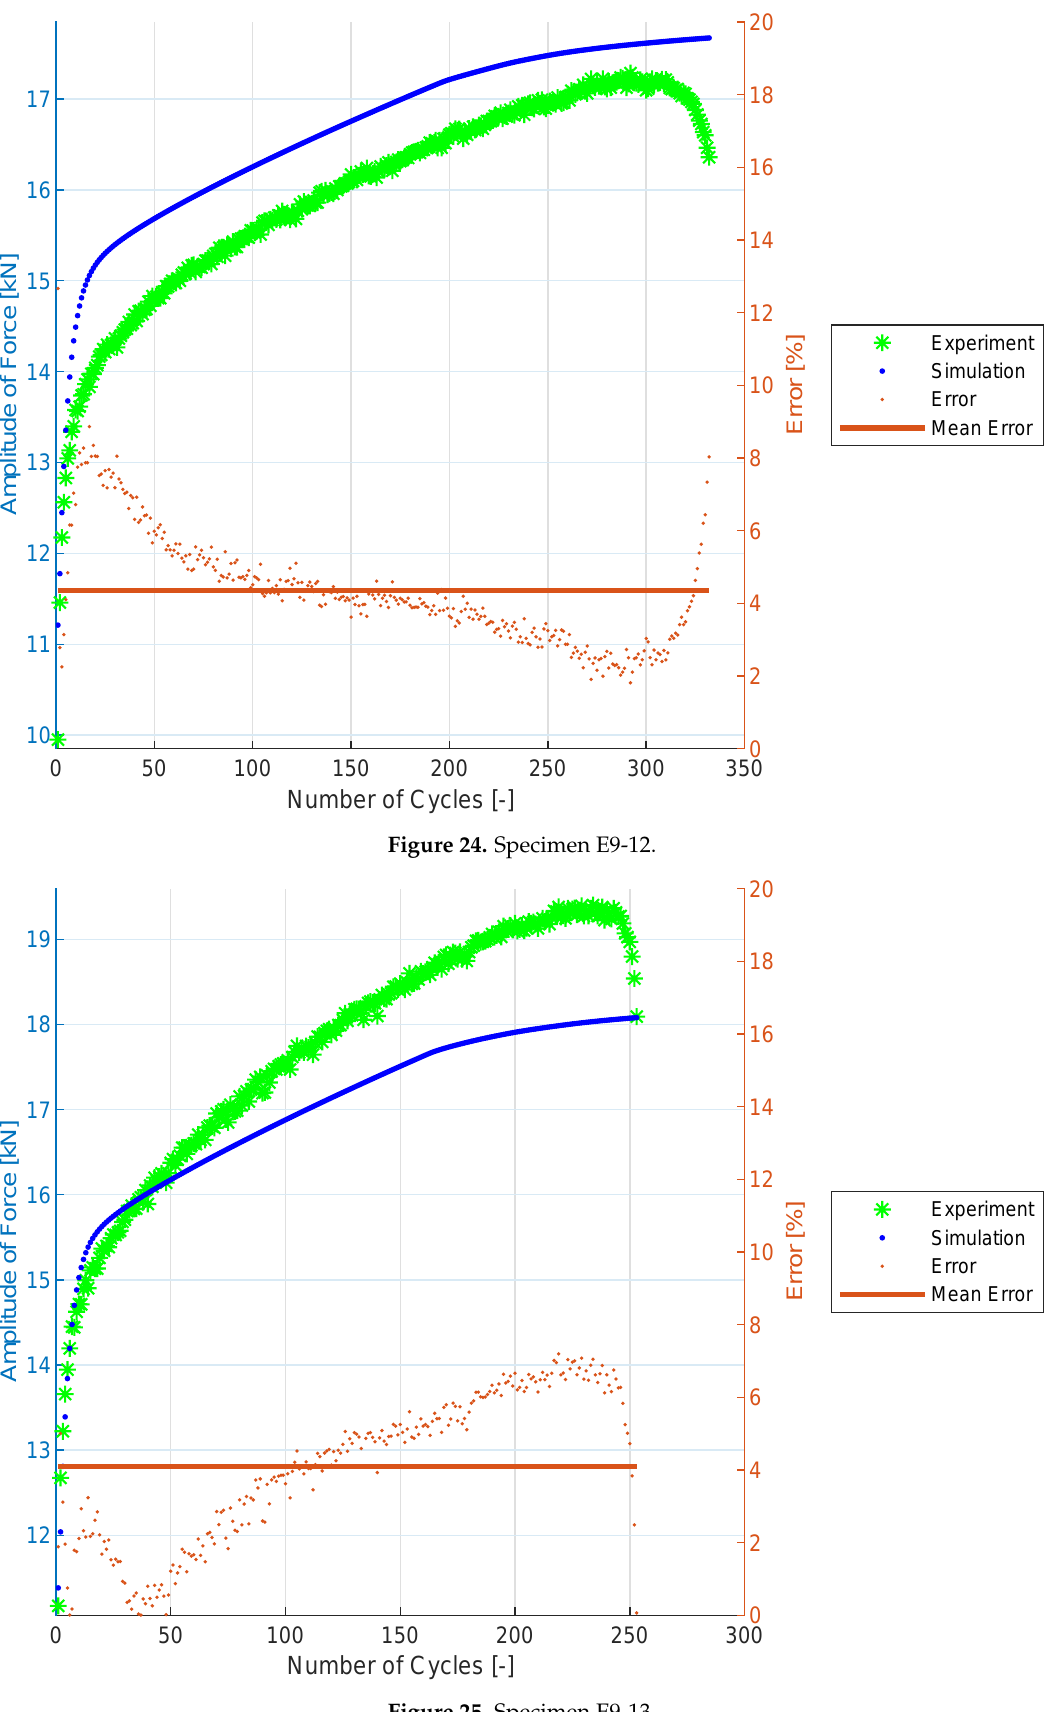
Figure 25. Specimen